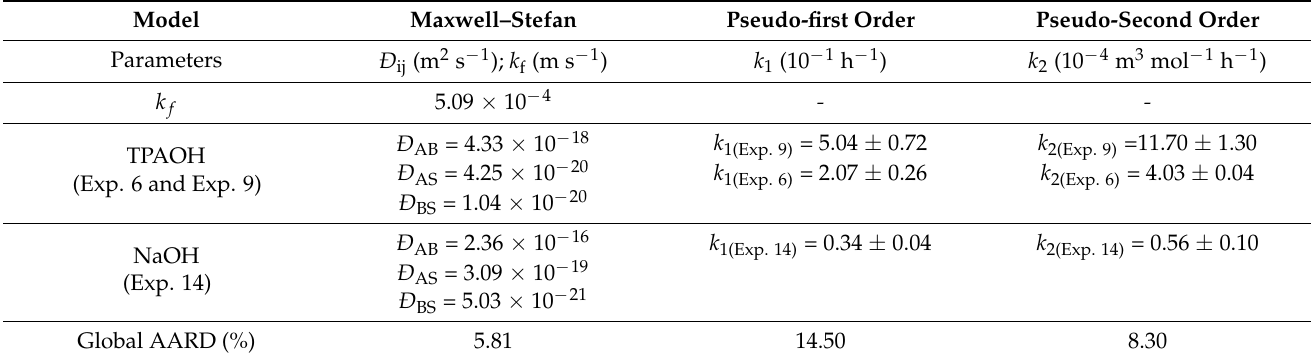
Table 3. Optimized parameters of Maxwell–Stefan, pseudo-first and pseudo-second order models, and respective calculated deviations (AARD).